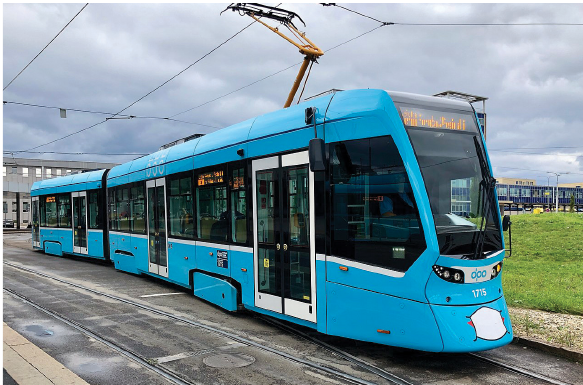
Figure 10. TANGO NF2 Nova tram type (Stadler,